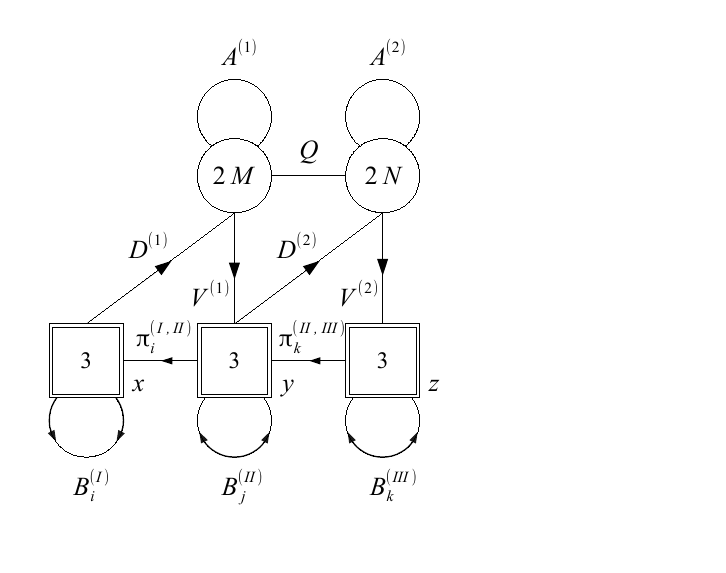
Figure 12 . The quiver representation of the self-dual theory, which we propose to have SU(3) 3 → E 6 enhancement. Two sets of singlets π ( I,II ) been added to Theory